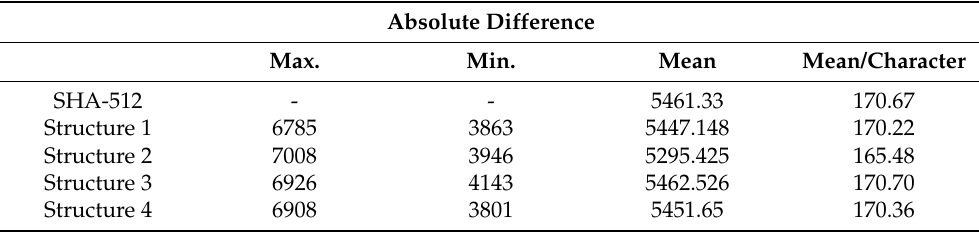
Table 14. Absolute differences between two hash values for 1000 different messages.